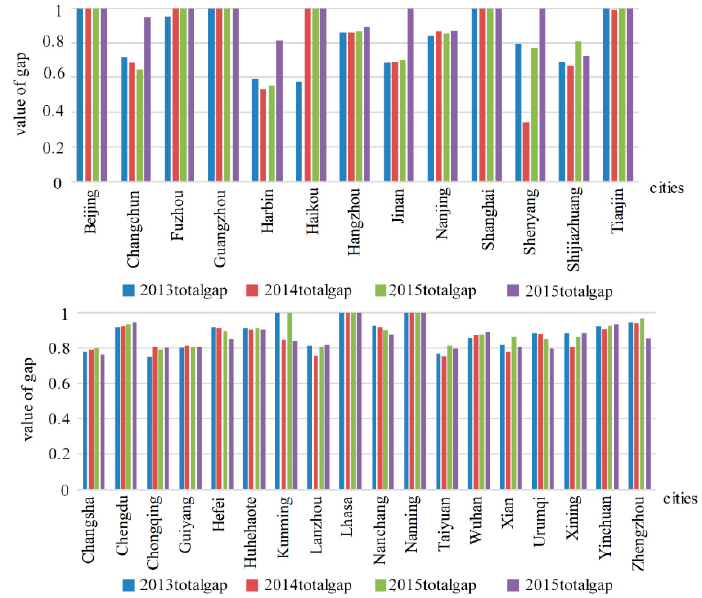
Figure 3. Efficiency gap for the eastern (the upper figure) and western (the lower figure) cities in